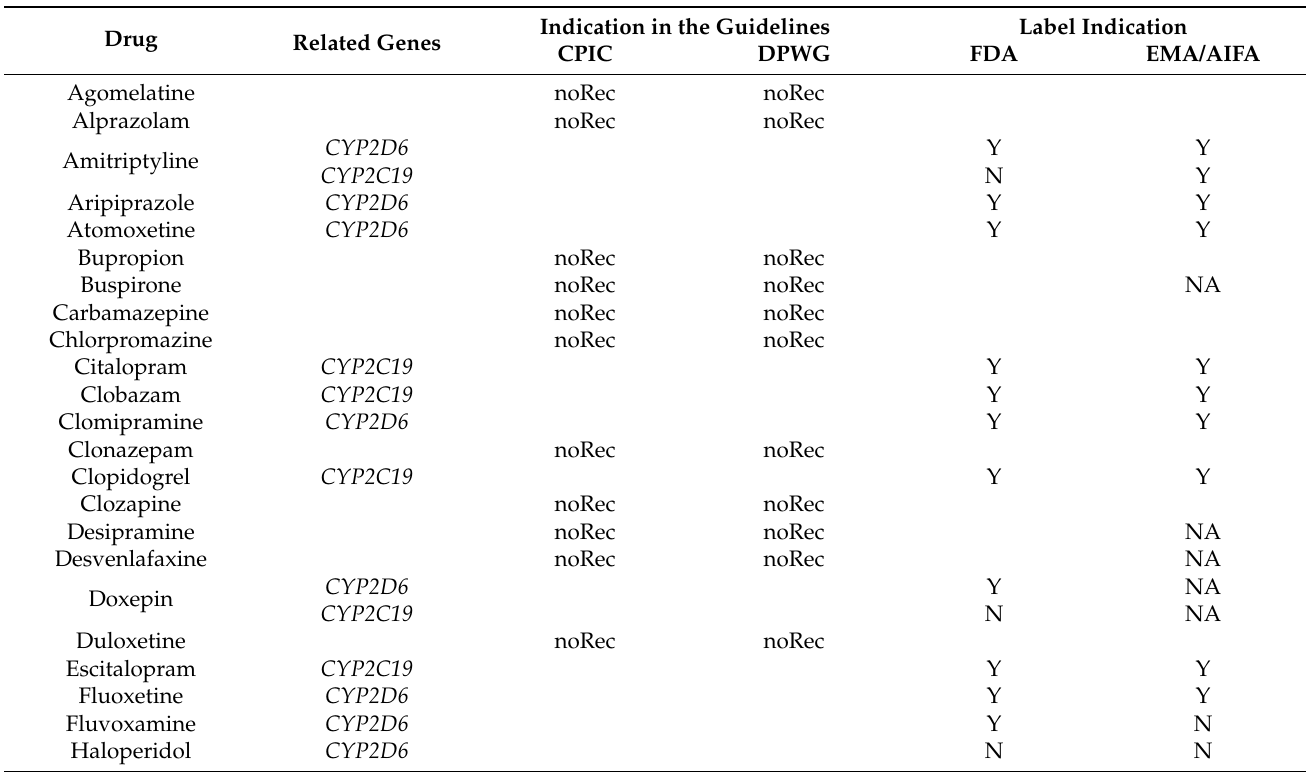
Table 4. Comparison between guidelines (CPIC and DPWG) and drug labels (FDA and EMA/AIFA) for pharmacogenetic data. Abbr.: FDA = Food and Drug Administration; EMA = European Medicines Agency; AIFA = Italian Medicines Agency; noRec = no recommendation reported in the guideline; N = no information about CYP phenotypes; Y = the label reports information about CYP phenotypes, with or without suggestion to investigate CYP genotype; NA: not approved. Indication in the Guidelines Label